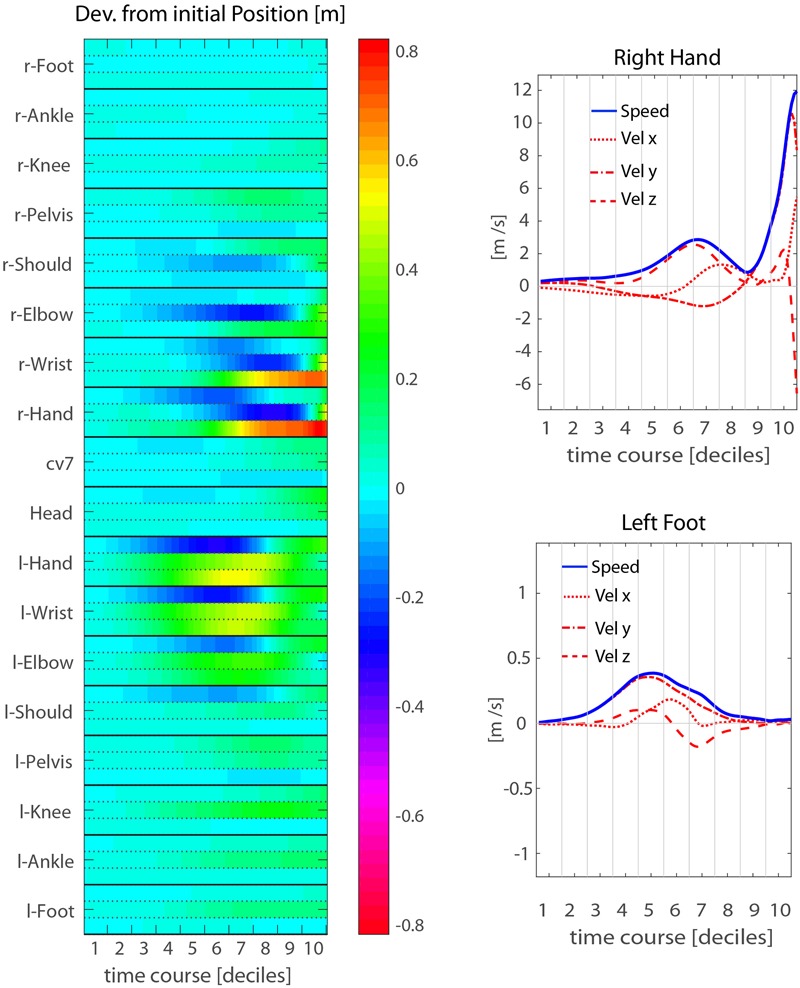
Mean throwing action kinematics of representative participant P14. (Left) The temporal evolution of the deviations from the initial position is shown for all joint-makers included in the analysis. The three rows associated to each joint-marker represent the values for the three spatial coordinates, [x,y,z] from top to bottom respectively. (Right) Examples of velocity and speed profiles from single joint-markers: right hand (upper) and left foot (lower). The participant’s throwing style is characterized by an elevation phase in which the throwing arm is risen while moving the hand backwards and to the right side, and by a concomitant left step forwards. While the elevation phase extends in time throughout the first eight deciles of the whole action duration, the forward-projection phase occurs late, across the 9th and 10th deciles.